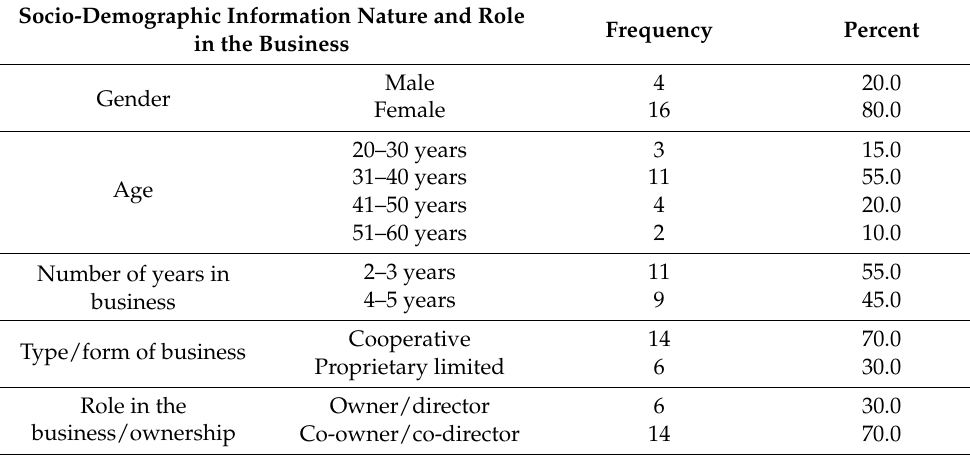
Table 1. Socio-demographic